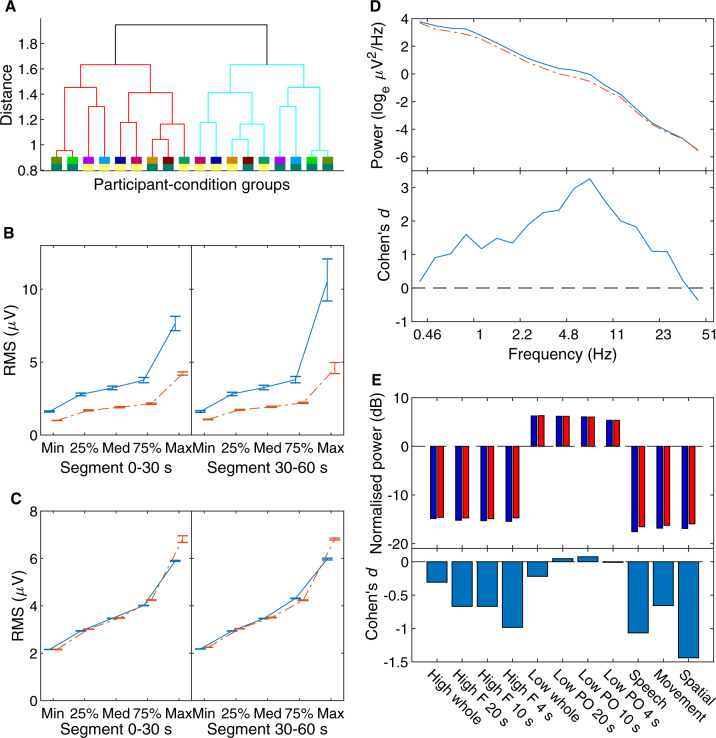
Step 4 blind classification results. The same format as in Fig. 5 besides (A), which shows the dendrogram on participant-condition group averages.